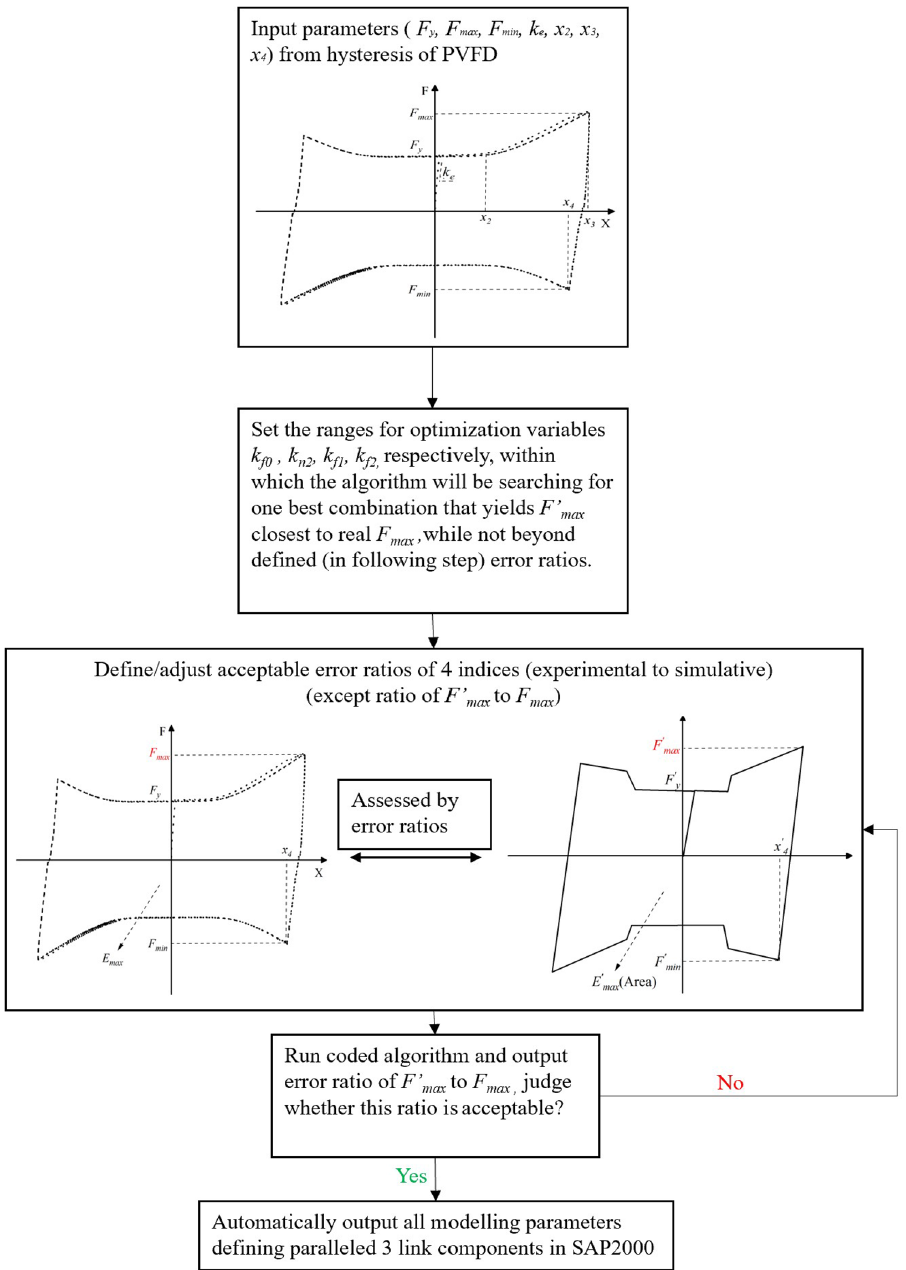
Fig. 14 Interactive workflow for generating optimized mod- elling